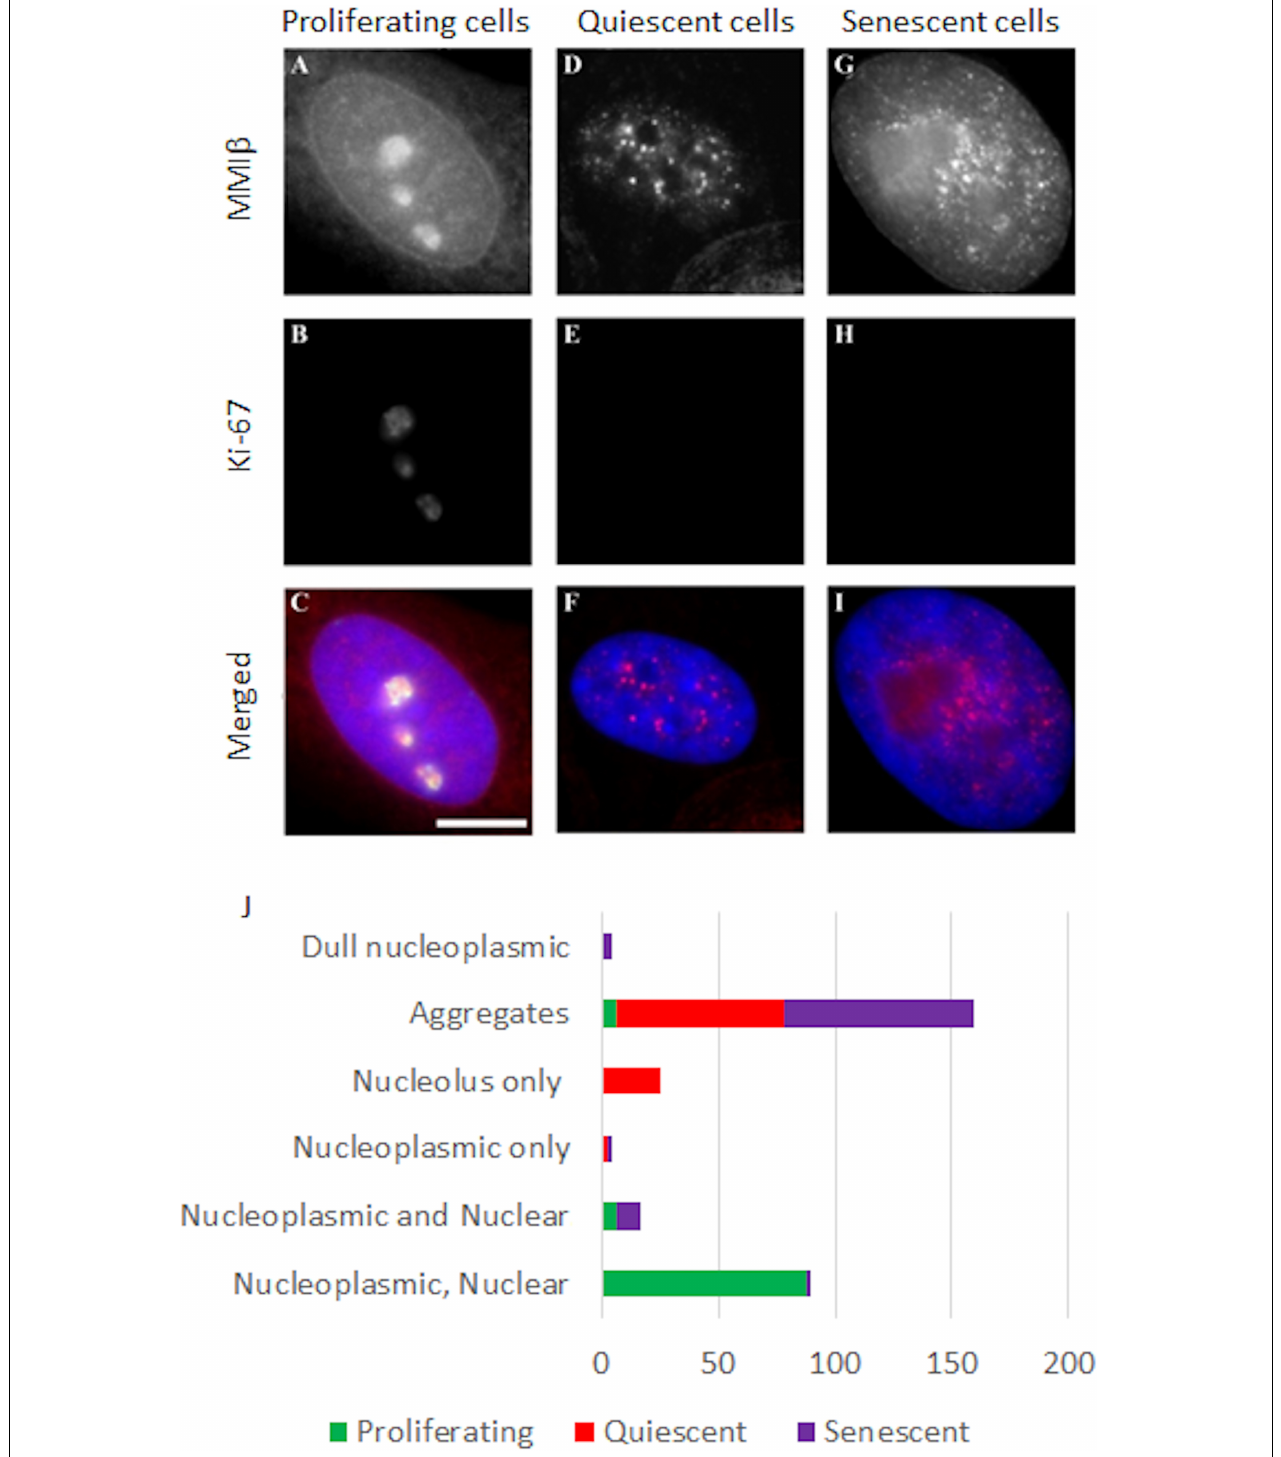
FIGURE 7 | Representative images displaying the distribution of NMI β in proliferating, quiescent and senescent HDFs. Young, serum starved young and senescent HDF were grown on glass coverslips, fixed with methanol:acetone and co-stained for nuclear myosin 1 β [red, (A,D,G) ] and pKi-67 [green, (B,E,H) ]. DNA is delineated by DAPI and merged images are displayed in panels (C,F,I) . Scale bar = 5 µ m. (J) displays the fractions of the different patterns of nuclear myosin 1 β -nucleoplasmic, nuclear rim and nucleolar; nucleoplasmic and nuclear rim, nucleoplasmic only, nucleolus only, aggregates and dull nucleoplasmic. Error with respect to standard deviation can be found in Supplementary Table 2